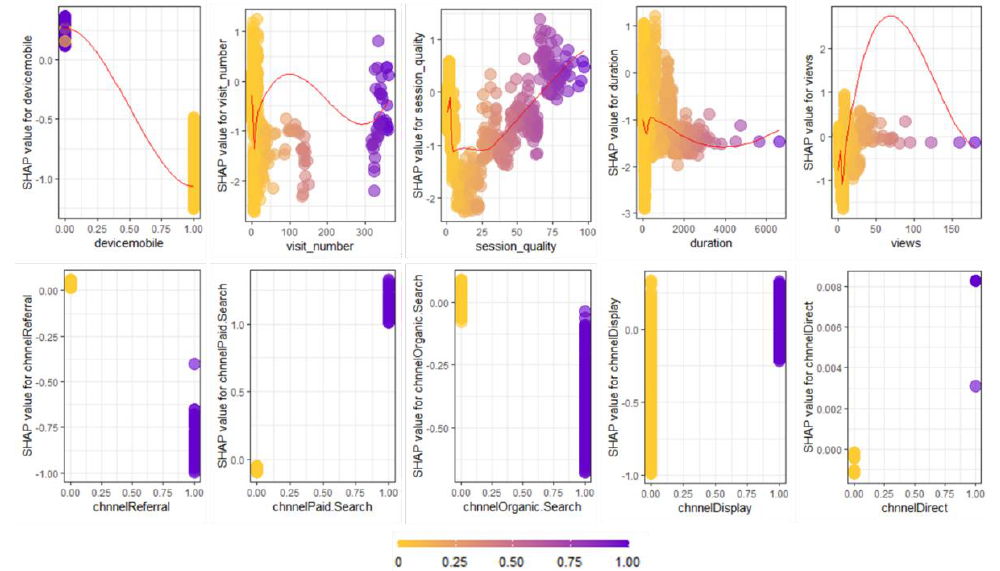
Figure 5. SHAP dependence plot.